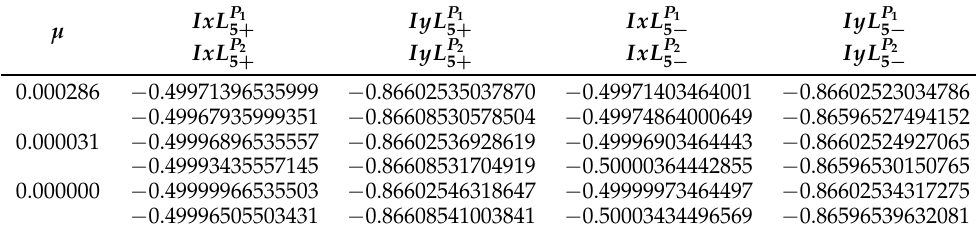
Figure 8. Eigenvalues versus µ 2 ∈ ( 10 − 10 ,10 − 7 ) of th Sun–Saturn system in the presence of the Kuiper belt effect near L 4 equilibrium point with µ 1 = 10 − 7 . Continuous lines denote the real part of the eigenvalues, and dashed lines denote the imaginary parts of the eigenvalues for collinear points. ( a ) Eigenvalues of perpendicular equilibrium point near L 4 toward smaller primary. ( b ) Eigenvalues of perpendicular equilibrium point near L 4 away from smaller primary. ( c ) Eigenvalues of inline equilibrium point near L 4 away from center. ( d ) Eigenvalues of inline equilibrium point near L 4 toward center. Table 14. Inline equilibrium solution near L 5 of different planetary